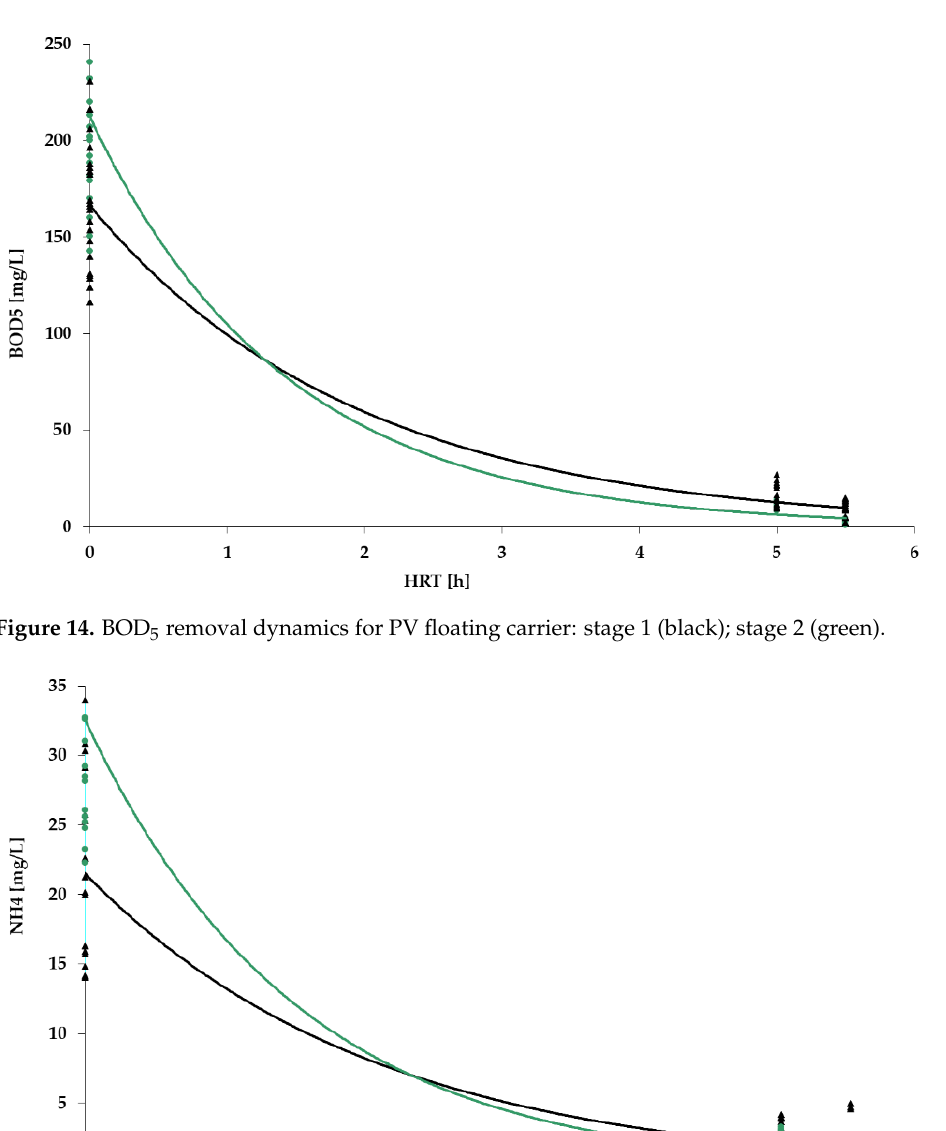
Figure 13. Scheme of the lab-scale bench in stage 2: 1 — wastewater influent; 2 — ASR; 3 — aeration